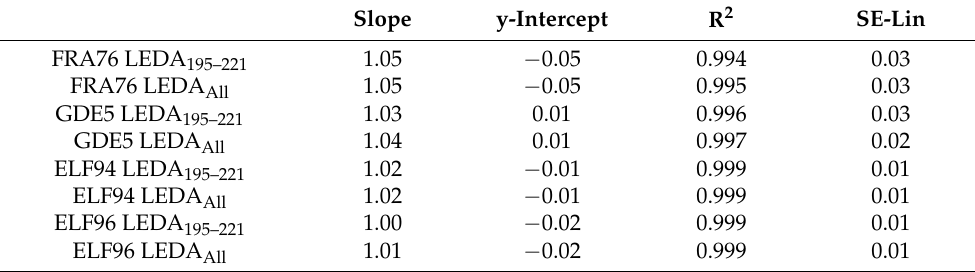
Table 1. Validation plot parameters (slope, y-intercept, determination coefficient or R2 and standard error of linear function or SE-Lin) obtained by the elaboration of MS/MS data of standard mixtures of each pair of isomers by the LEDA matrices described above.